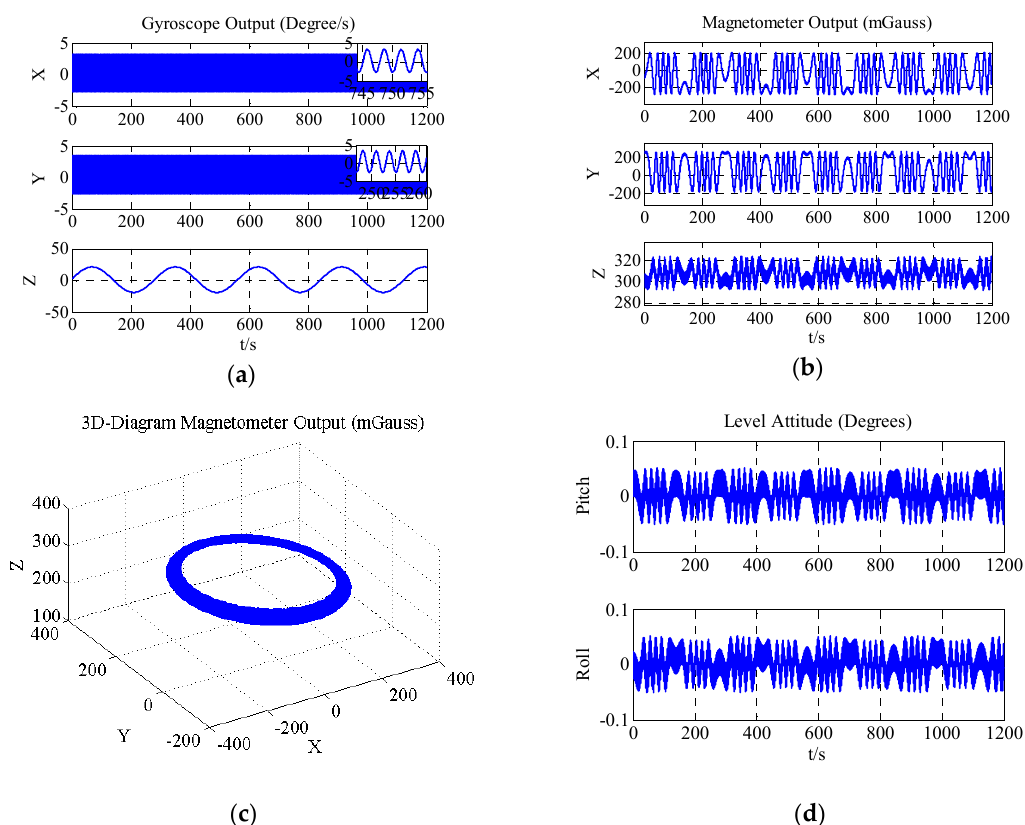
Figure 2. ( a ) Three-axis gyroscope output; ( b ) Three-axis magnetometer output; ( c ) 3D-diagram magnetometer output; ( d ) Level attitude of system.